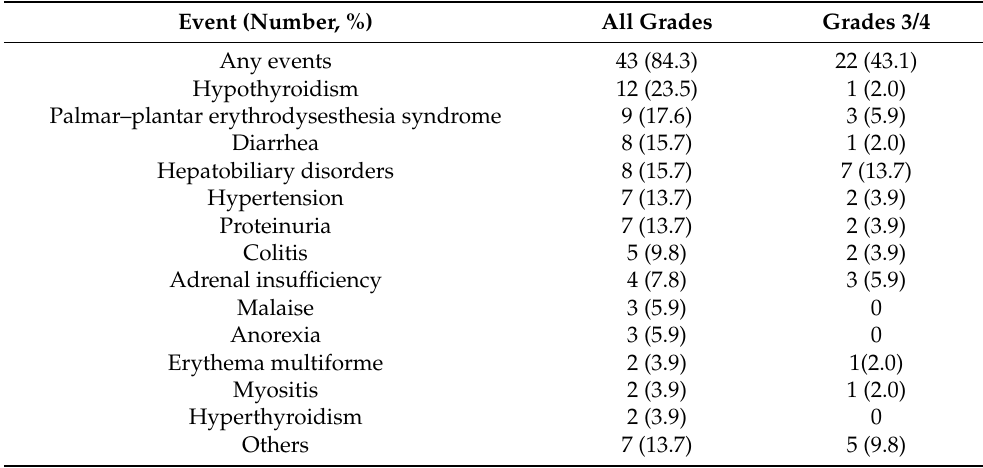
Table 4. Treatment-related adverse events of immune checkpoint inhibitors and tyrosine kinase inhibitors. Event (Number, %) All Grades Grades 3/4 Any events Palmar–plantar erythrodysesthesia syndrome